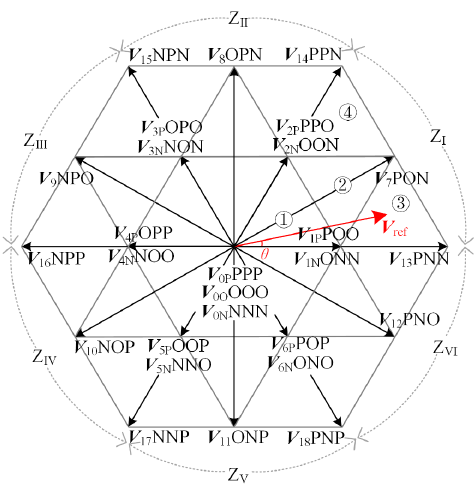
Figure 2. The space vector diagram of three-level inverter.